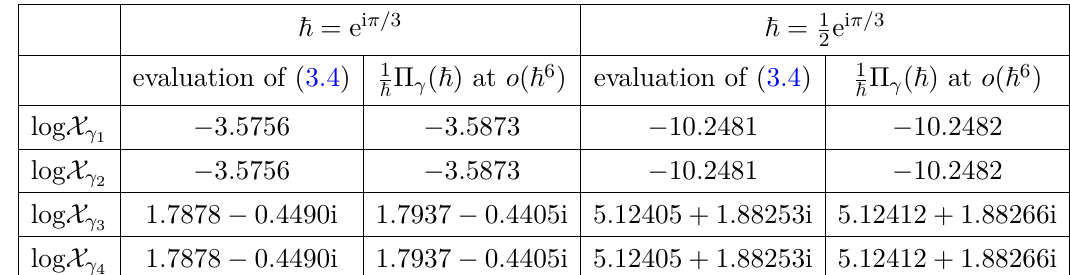
= u = 0 and Λ = 1 1 2